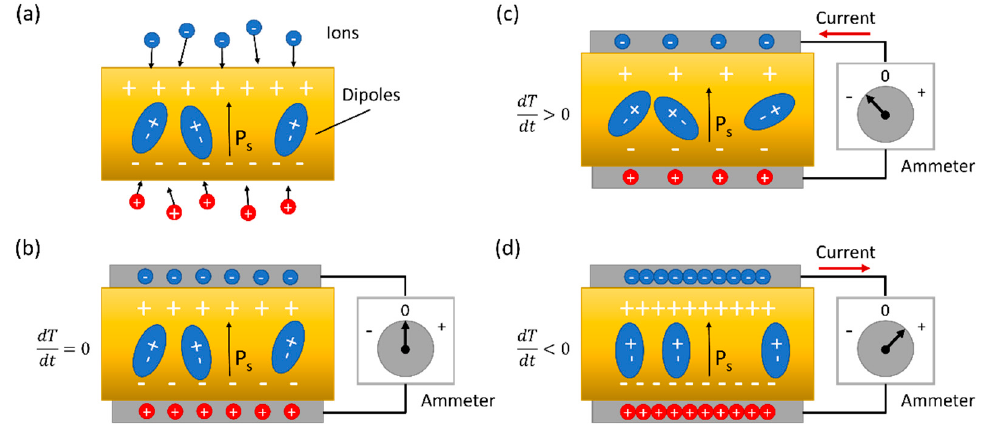
Figure 5. Physical principle of pyroelectric generator: ( a ) ions and dipoles in pyroelectric material, ( b ) without temperature variation, there is no current, ( c ) increase in temperature tends to decrease polarization ( d ) decrease in temperature leads to increase of polarization [37].